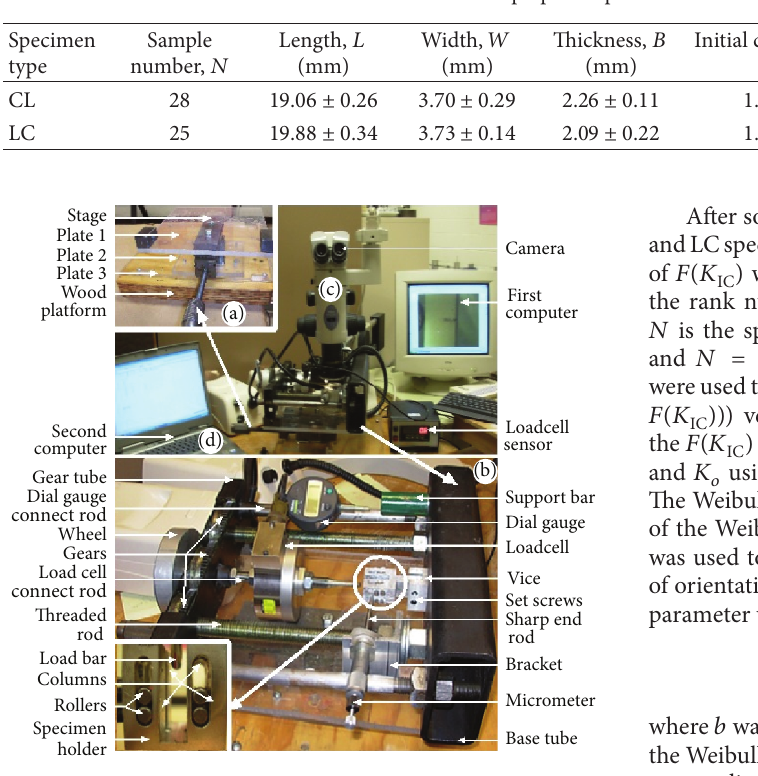
Figure 2: The fabricated experimental setup used in the study. The setup consists of (a) stage mechanism, (b) specimen loading, holding, aligning, and measuring systems, (c) camera system, and (d)